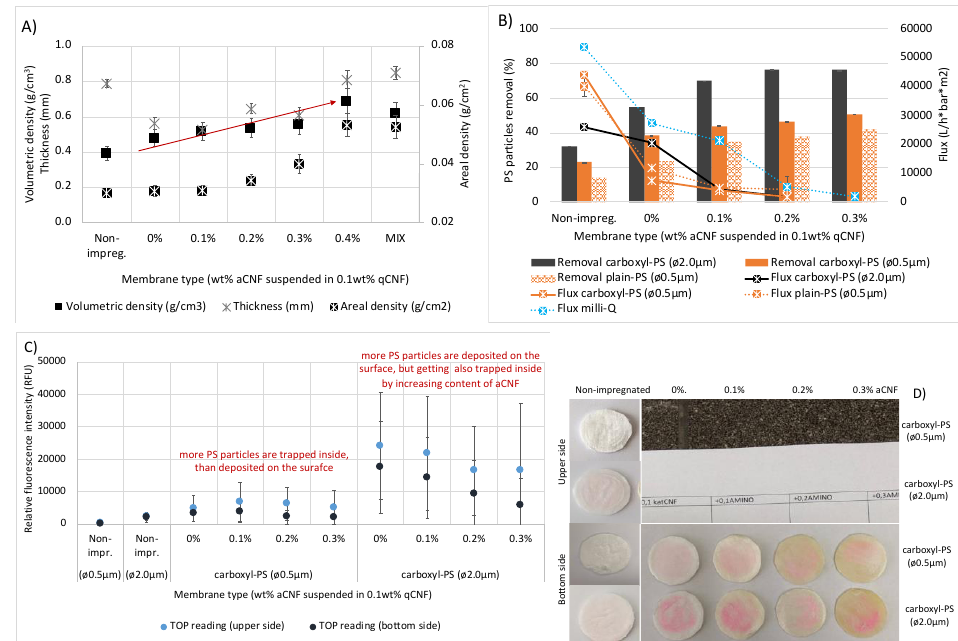
Figure 3. SEM micrographs of the cross section ( top ) and surface ( bottom ) of differently prepared individual (single-layered) fibrous membranes, namely, impregnated with 0.1 wt% quaternised cel- lulose nanofibrils (qCNF), with or without the addition of 0.4 wt% amino-hydrophobised CNF (aCNF).